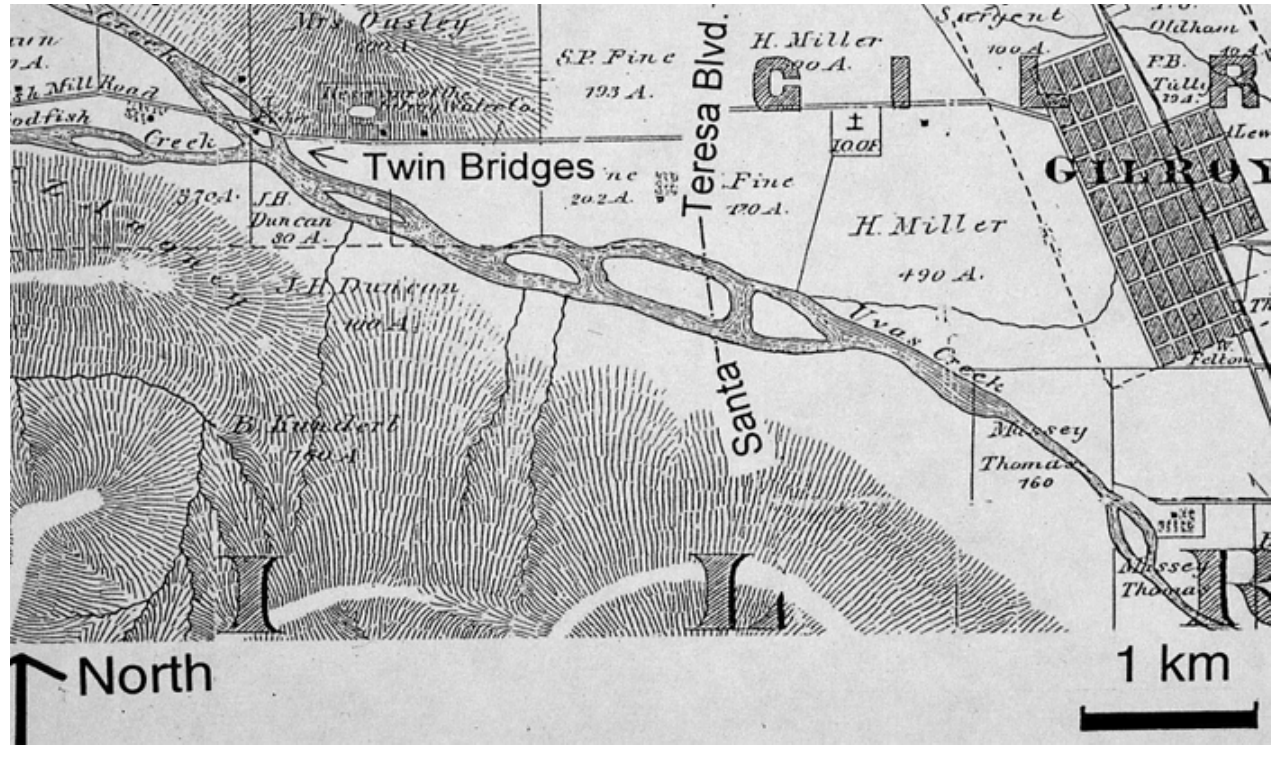
Fig. 9 . Detail from the Santa Clara County Atlas of 1876 by Thompson & Crest (courtesy of the Earth Sciences Map Collection of the University of California at